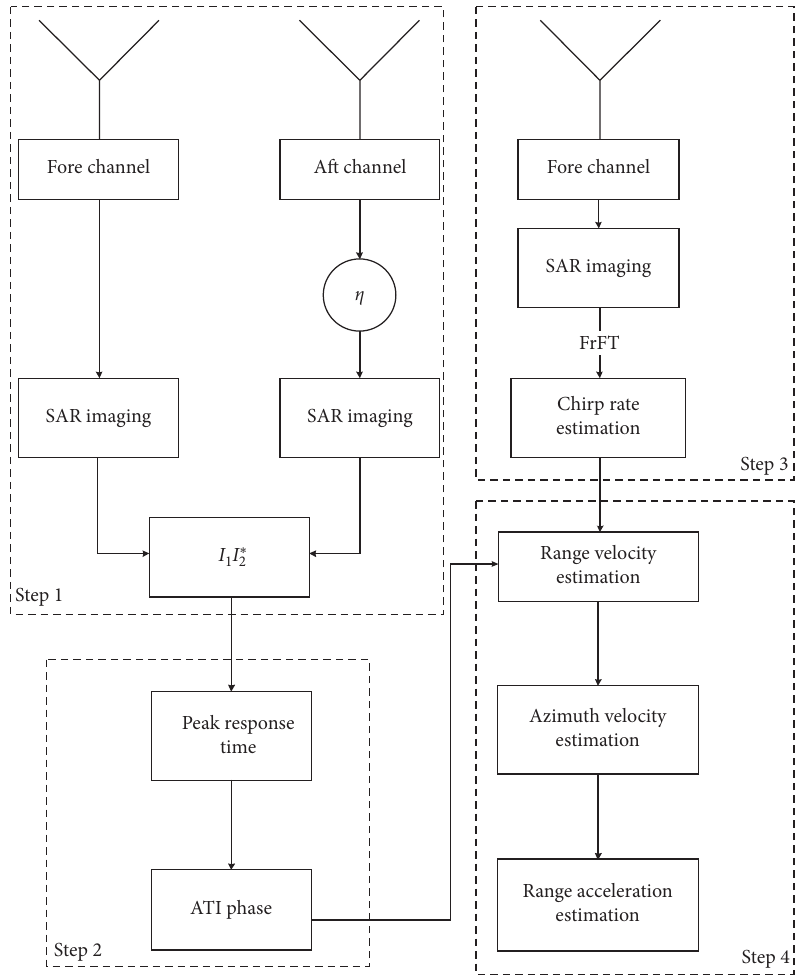
Figure 2: Flowchart describing the proposed method where the notation η denotes the image registration